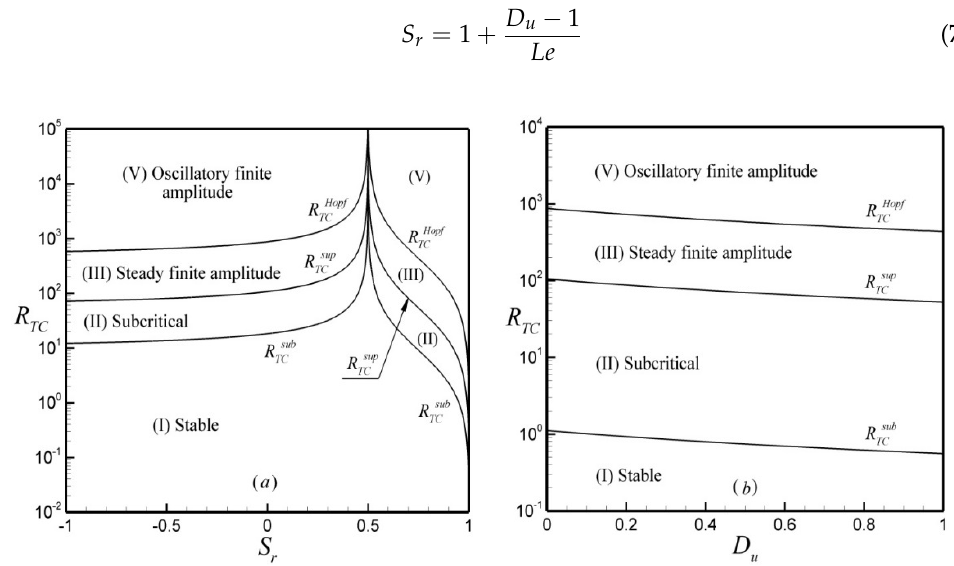
Figure 13. Critical Rayleigh numbers R sub and ( b ) Dufour parameter D u ( S r = 0 ) , for Da e = 10 − 4 , Le = 2, ξ = 0, and ε =